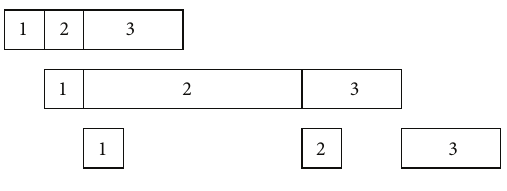
Figure 1: Gantt chart of Example